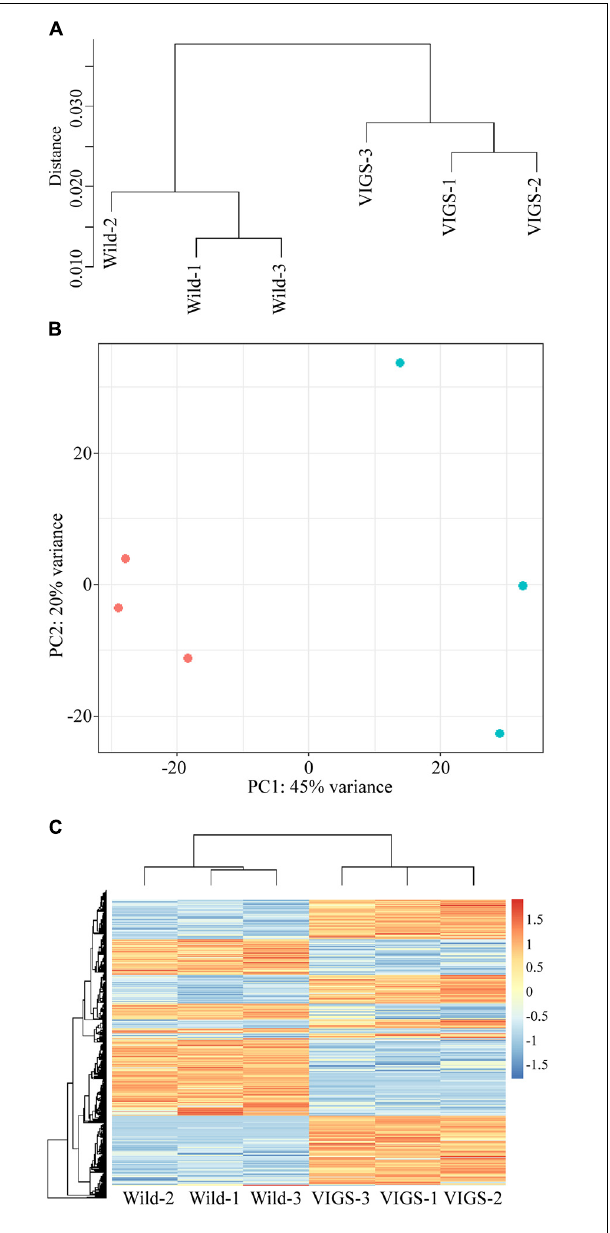
FIGURE 5 | Analysis of differentially expressed genes (DEGs) between transcriptomes of wild-type and VIGS-treated plants. (A) Hierarchical clustering shows dissimilarity among the transcriptome samples; distance is calculated by Pearson correlation coefficient. (B) Principal component analysis of the transcriptome samples. Red points represent wild-type plants; blue points represent pTRV2: EcINP1 -treated plants. (C) Heatmap of transcriptomes of wild-type and pTRV2: EcINP1 -treated plants. Heatmap scale bars indicate log 2 fold